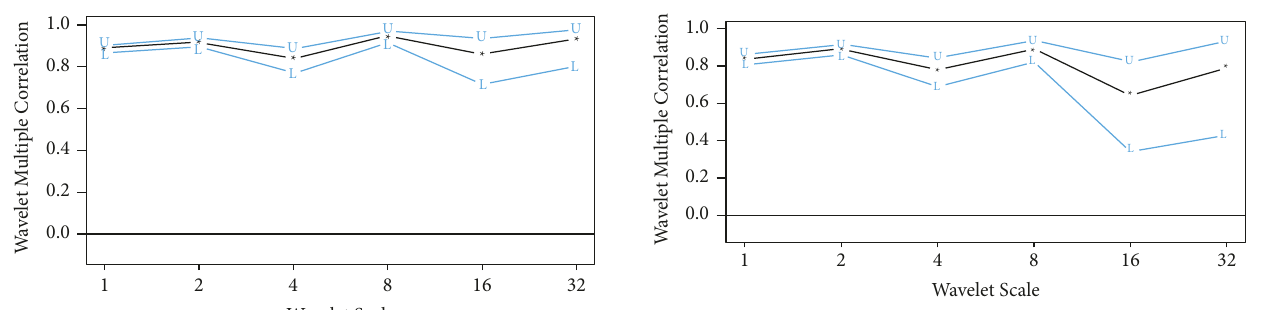
Figure 12: Wavelet multiple correlation between systematic risk of Europe (18/08/2010–03/11/2020). The blue lines denote upper (U) and lower limits (L) of the 95% confidence interval, respectively.